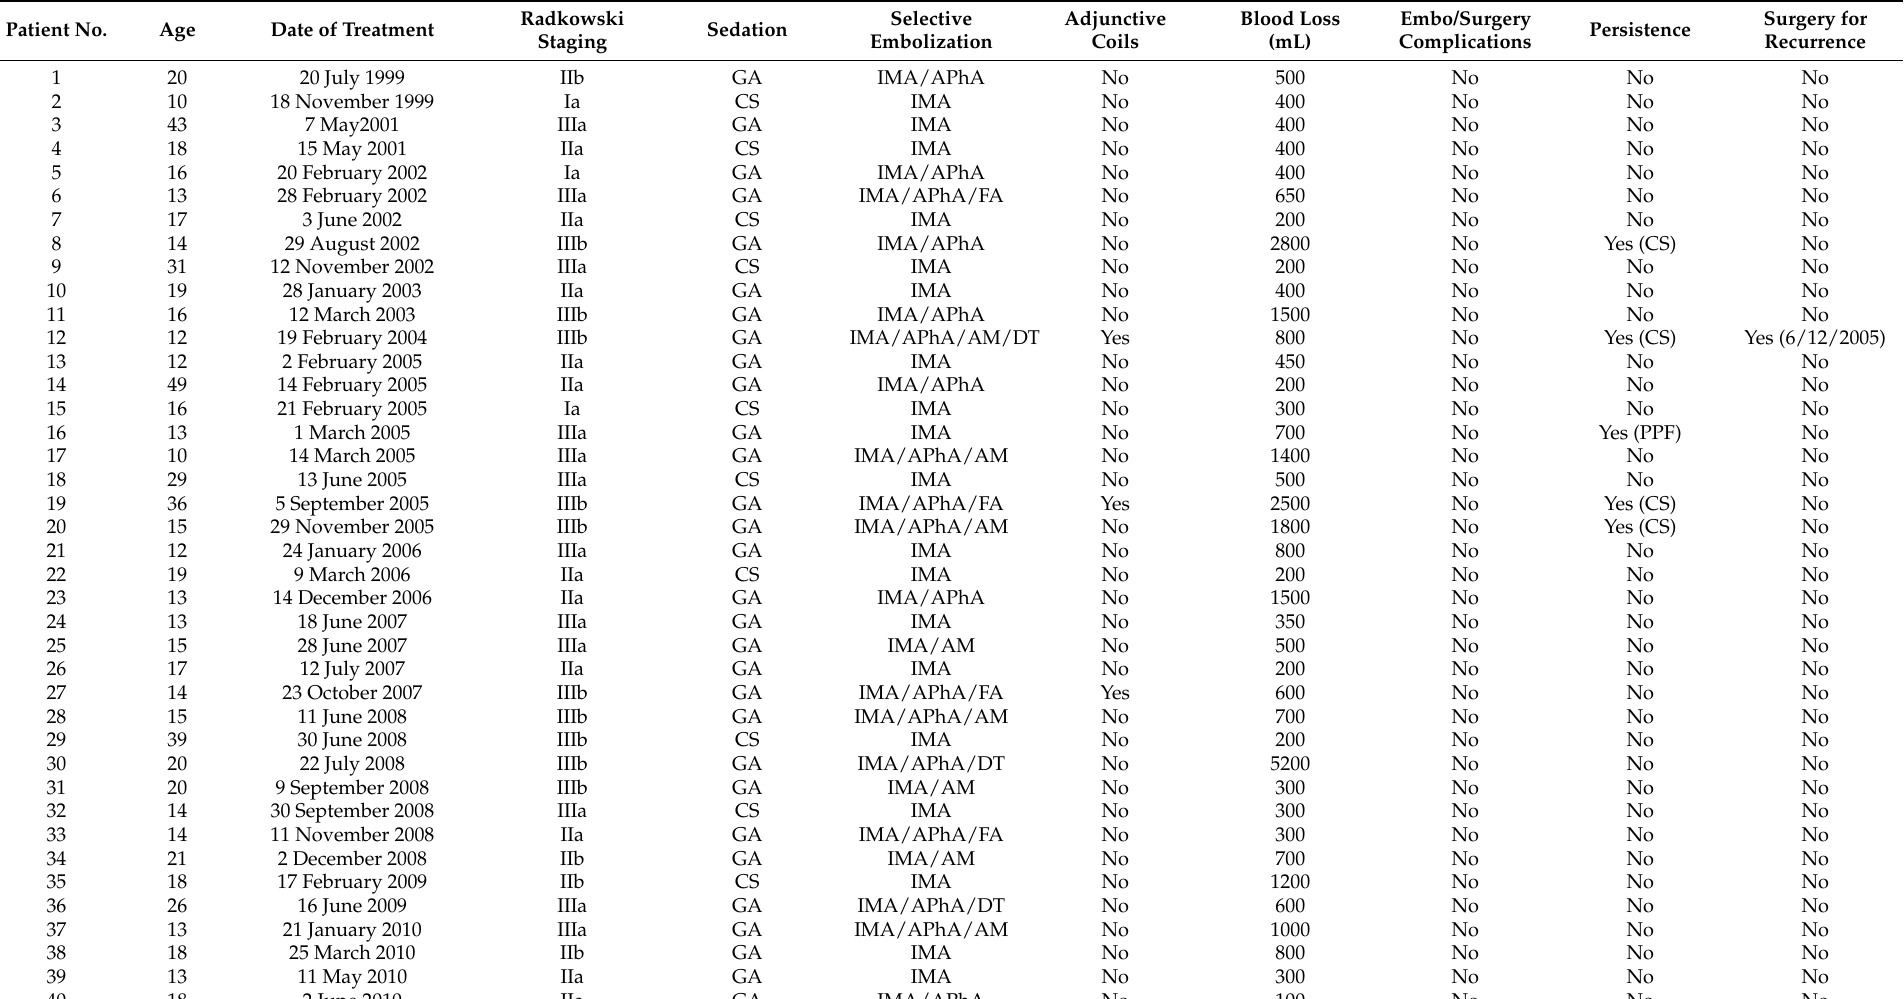
Table A1. Demographic, procedural, surgical and follow-up data of patients treated in the